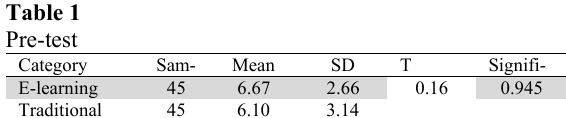
T-test results for the two categories of e-learning and